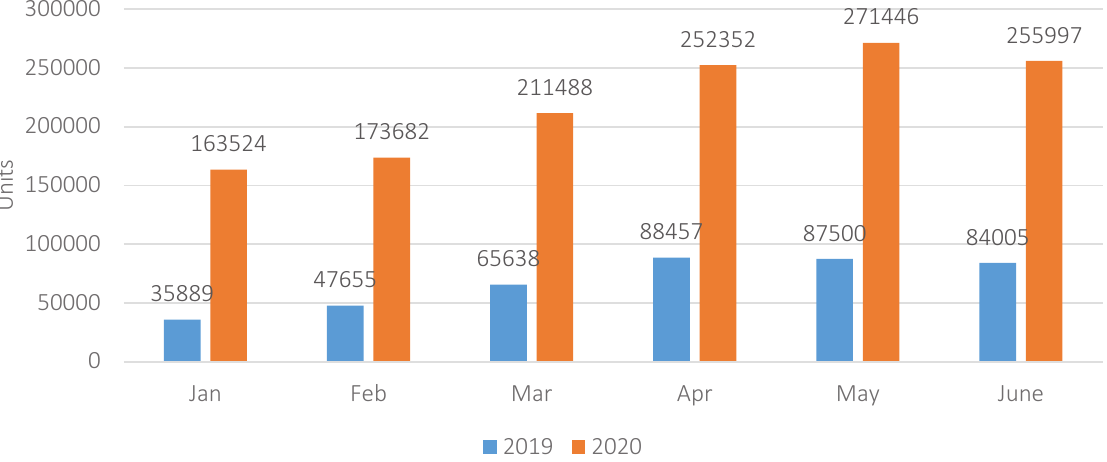
Figure 5. Dynamics of the number of electronic auto liability insurance policies